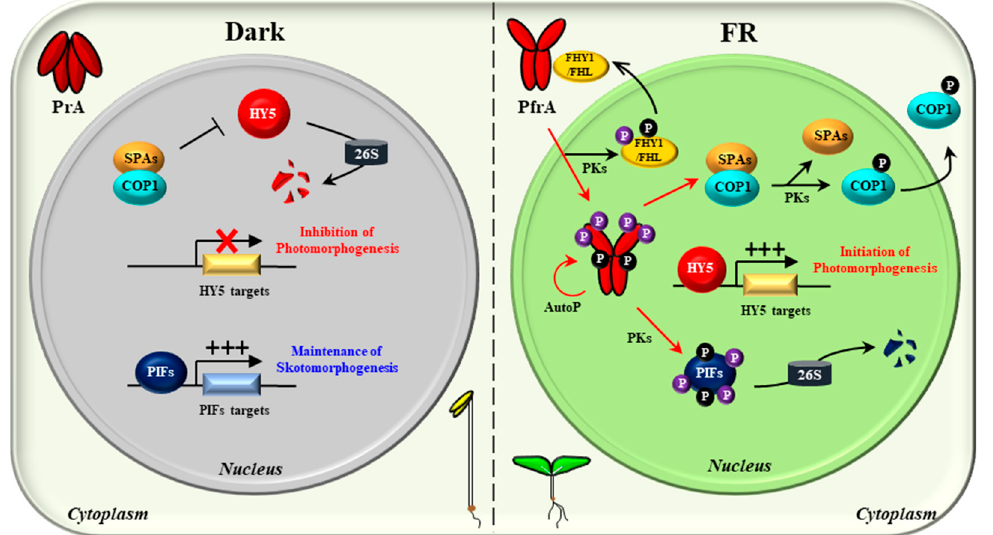
Figure 5. A model for phyA-mediated plant light signaling as a protein kinase. In the dark (left), phyA is biosynthesized as the Pr form (PrA) and accumulates in the cytoplasm. PIFs accumulated in the nucleus regulate transcription of genes to sustain skotomorphogenesis. At the same time, the COP1/SPA complex degrades HY5 via the ubiquitin/26S proteasome pathway to prevent photomor- phogenesis. Under FR light (right), phyA is photoactivated to the Pfr form (PfrA) and translocalized into the nucleus using FHY1/FHL shuttle. As a protein kinase, PfrA phosphorylates PIFs to induce the degradation of PIFs, and inactivates COP1/SPAs by inducing the dissociation of the complex. As a result, HY5 is accumulated and induces the transcription of photoresponsive genes to initiate photomorphogenesis. In addition, autophosphorylation of phyA (AutoP) occurs for signal desensi- tization by inducing rapid degradation of phyA. Red arrows represent the molecular mechanisms of phyA to induce photomorphogenesis (labeled ⓟ in purple), while black arrows represent the generally known mechanisms in previous studies. Besides phyA, other protein kinases (PKs) are also possible to involve in the phosphorylation of phyA (hinge region), FHY1/FHL, COP1, and PIFs (labeled ⓟ in black).